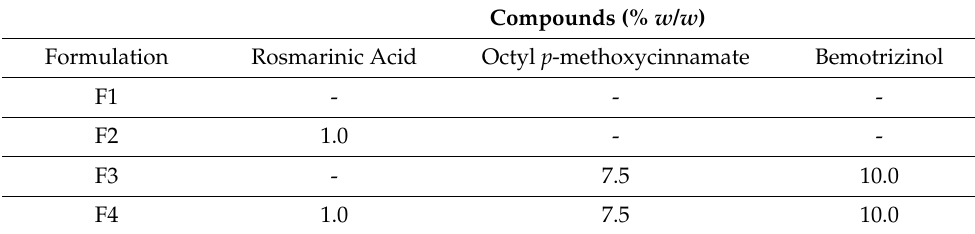
Table 1. Composition of the active ingredients of the